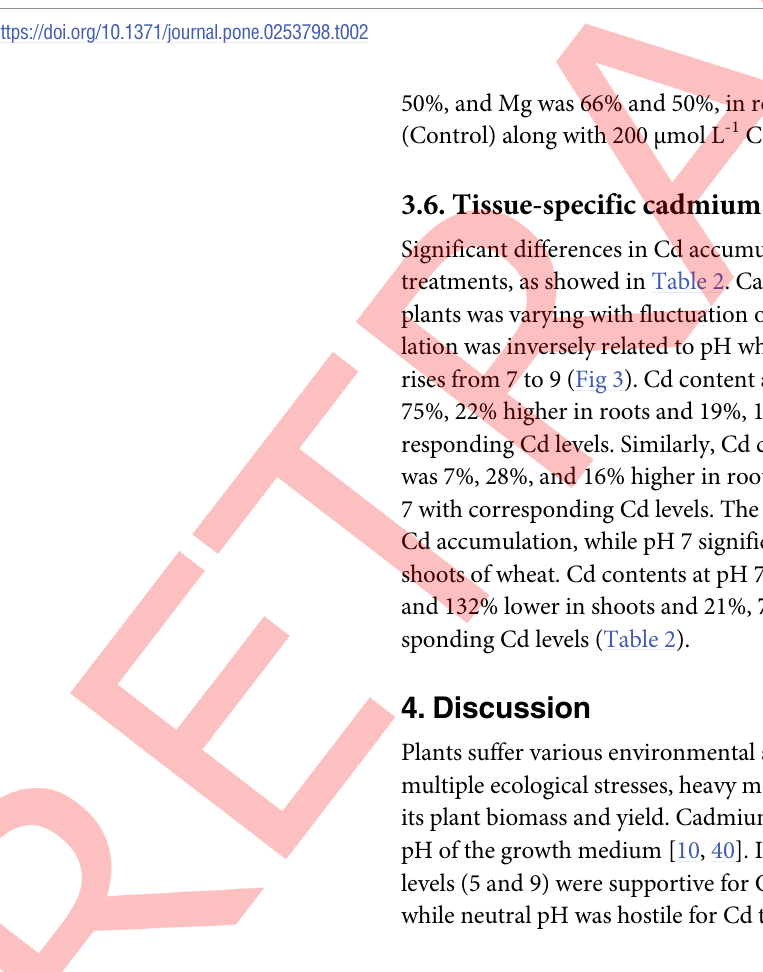
The values are expressed as the mean ± SD of three random replications of two independent experiments. The different superscript letters within a column indicate significant differences at p <